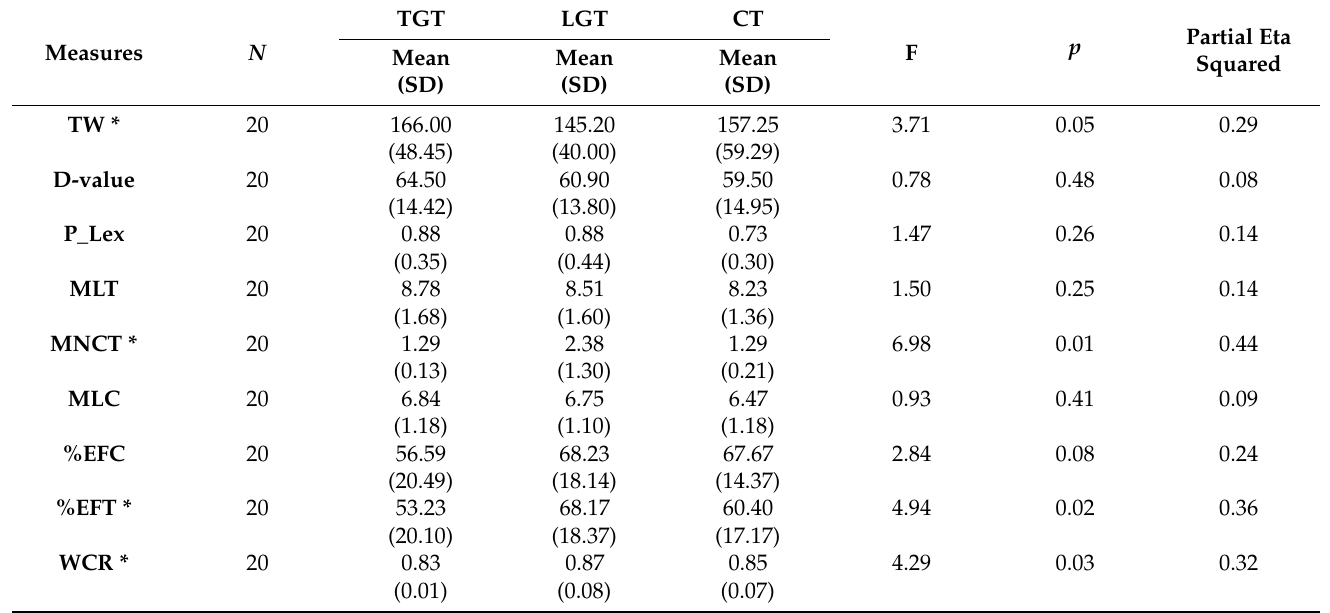
Table 2. Descriptive statistics and repeated measures ANOVA test results for Chinese students studying in China